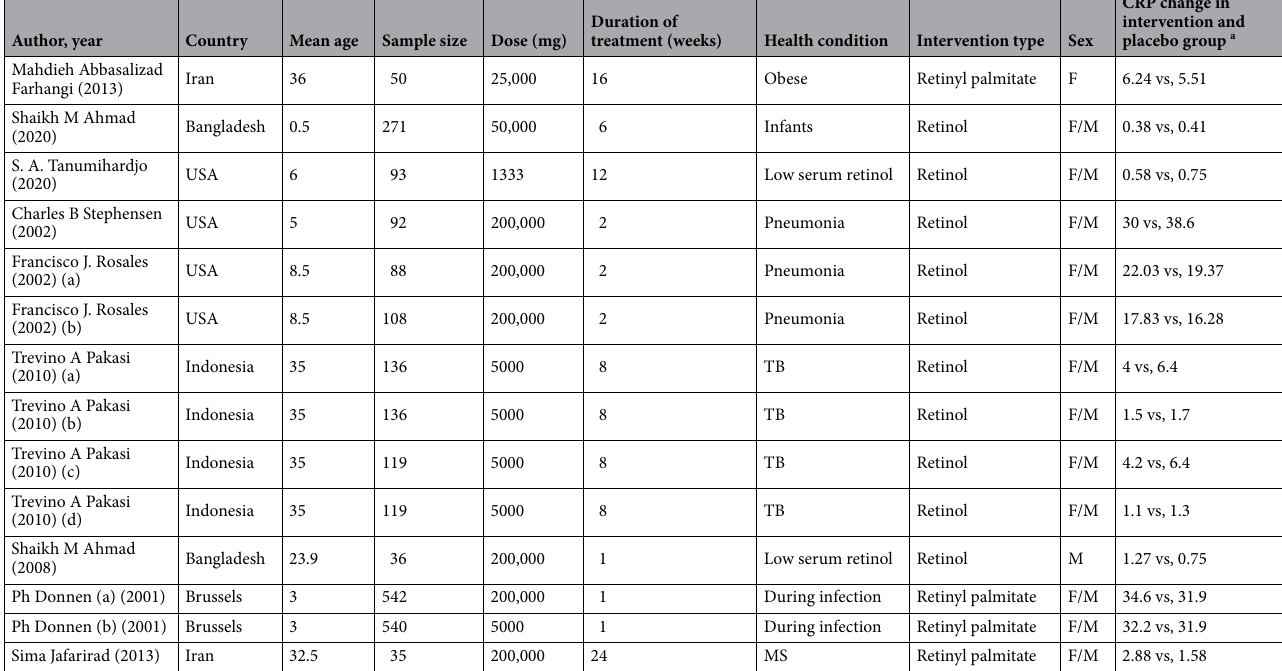
Table 1. The characteristics of included studies for analysis. Summary of clinical trials on the effects of vitamin A supplementation on inflammatory biomarker (CRP). CRP C-reactive protein, TB tuberculosis, M male, F female, a Changes in cytokine concentrations are presented by common units for CRP (mg/L).